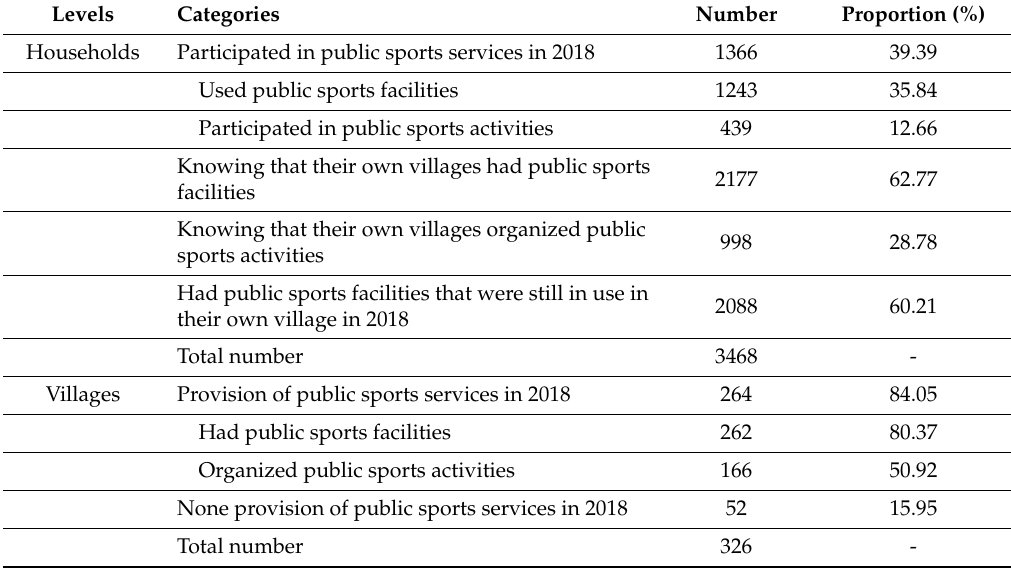
Table 1. Statistics of the variables related to community sports provision in the